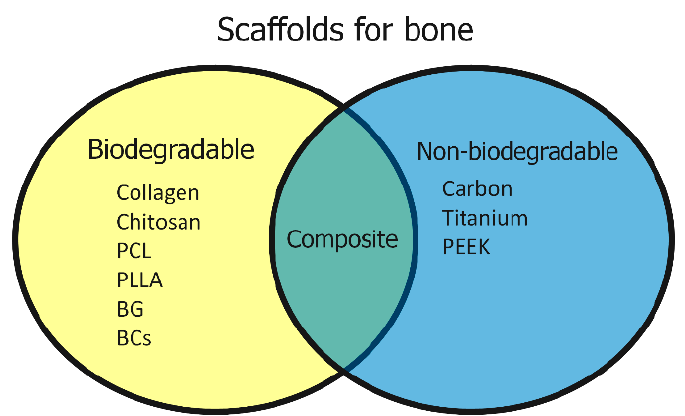
Figure 1. Sca ff olds for bone regeneration include biodegradable and nonbiodegradable sca ff olds, as Figure 1. Scaffolds for bone regeneration include biodegradable and nonbiodegradable scaffolds, as well as composite sca ff olds comprised of a combination of each material. PCL (polycaprolactone), BCs well as composite scaffolds comprised of a combination of each material. PCL (polycaprolactone), (bioresorbable ceramics), BG (bioactive glass), PLLA (poly- l -lactic) acid, PEEK BCs (bioresorbable ceramics), BG (bioactive glass), PLLA (poly-L-lactic) acid, PEEK (polyetheretherketone).